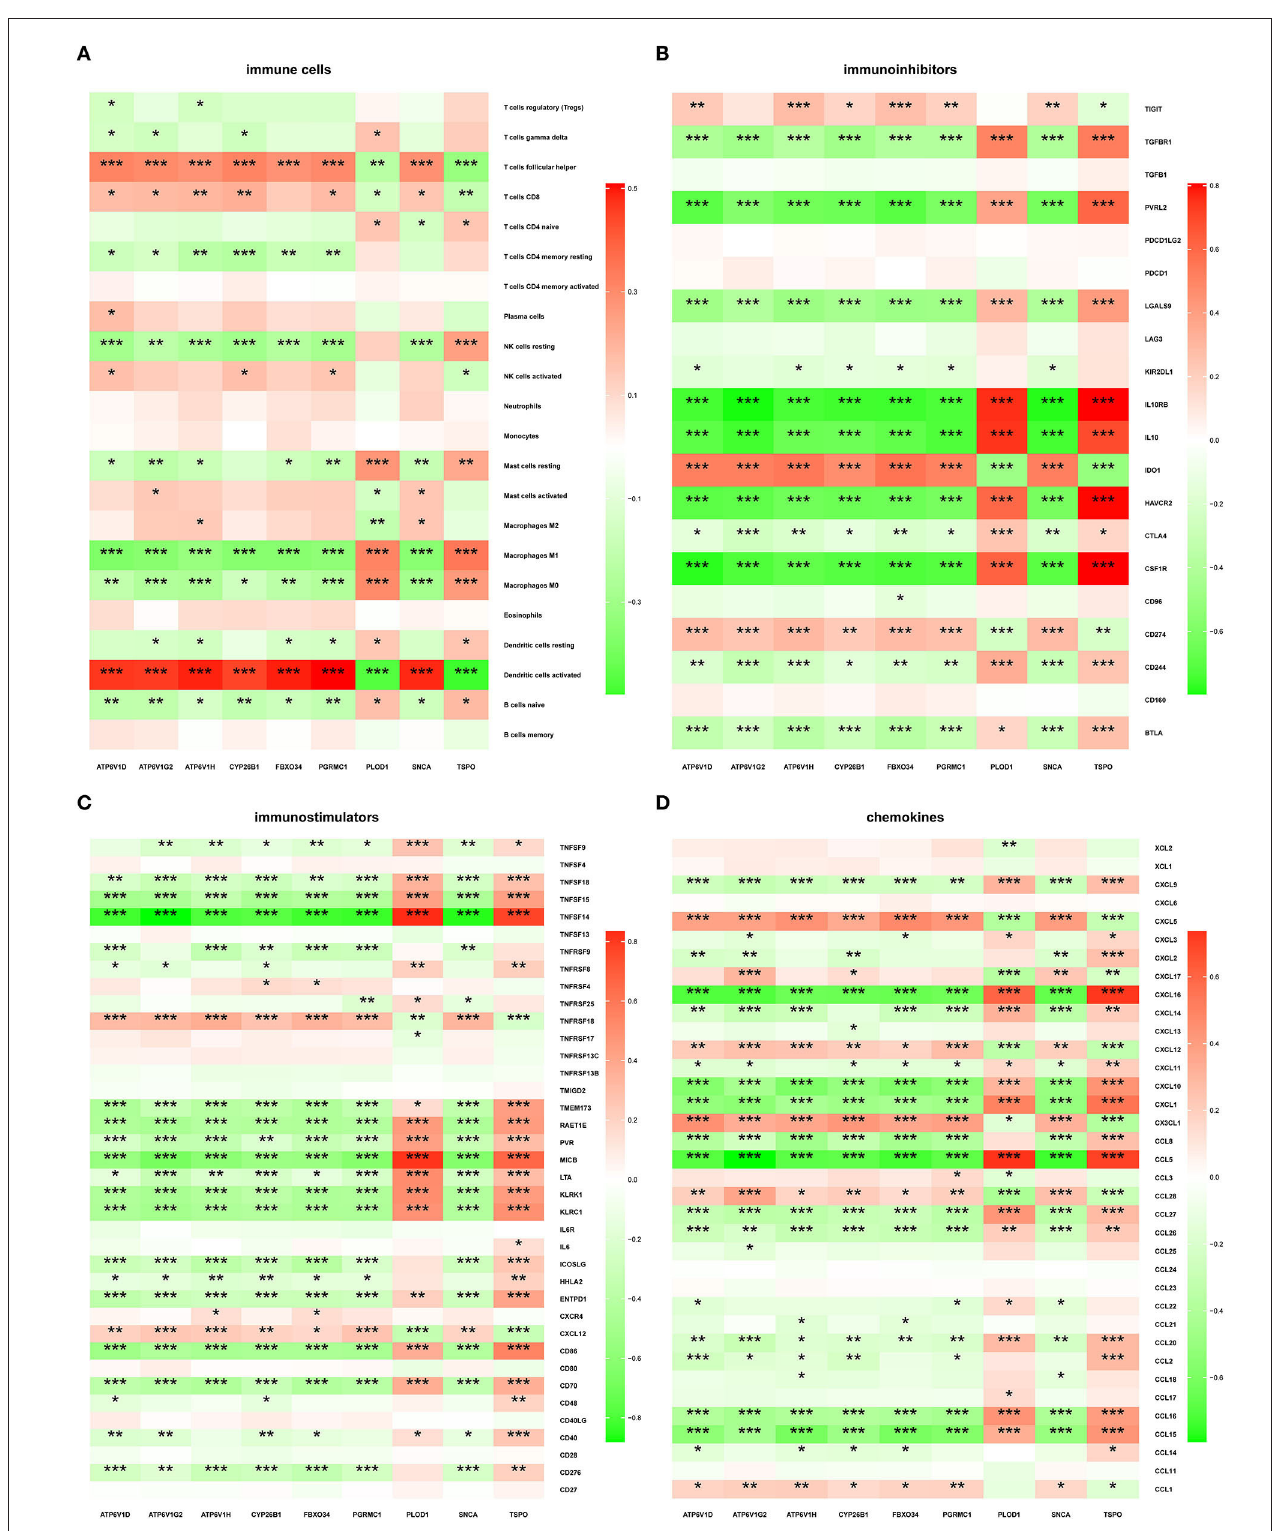
FIGURE 9 | Correlation of hub genes with immune cells and different immune factors. (A) Immune cells, (B) immunoinhibitors, (C) immunostimulators, and (D) chemokines.